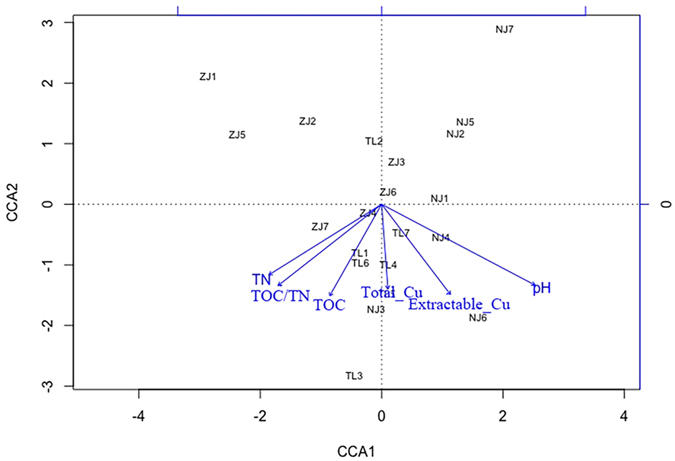
Canonical correspondence analysis (CCA) of bacterial community composition and environmental factors.TOC/TN and pH are significantly related to bacterial community composition.